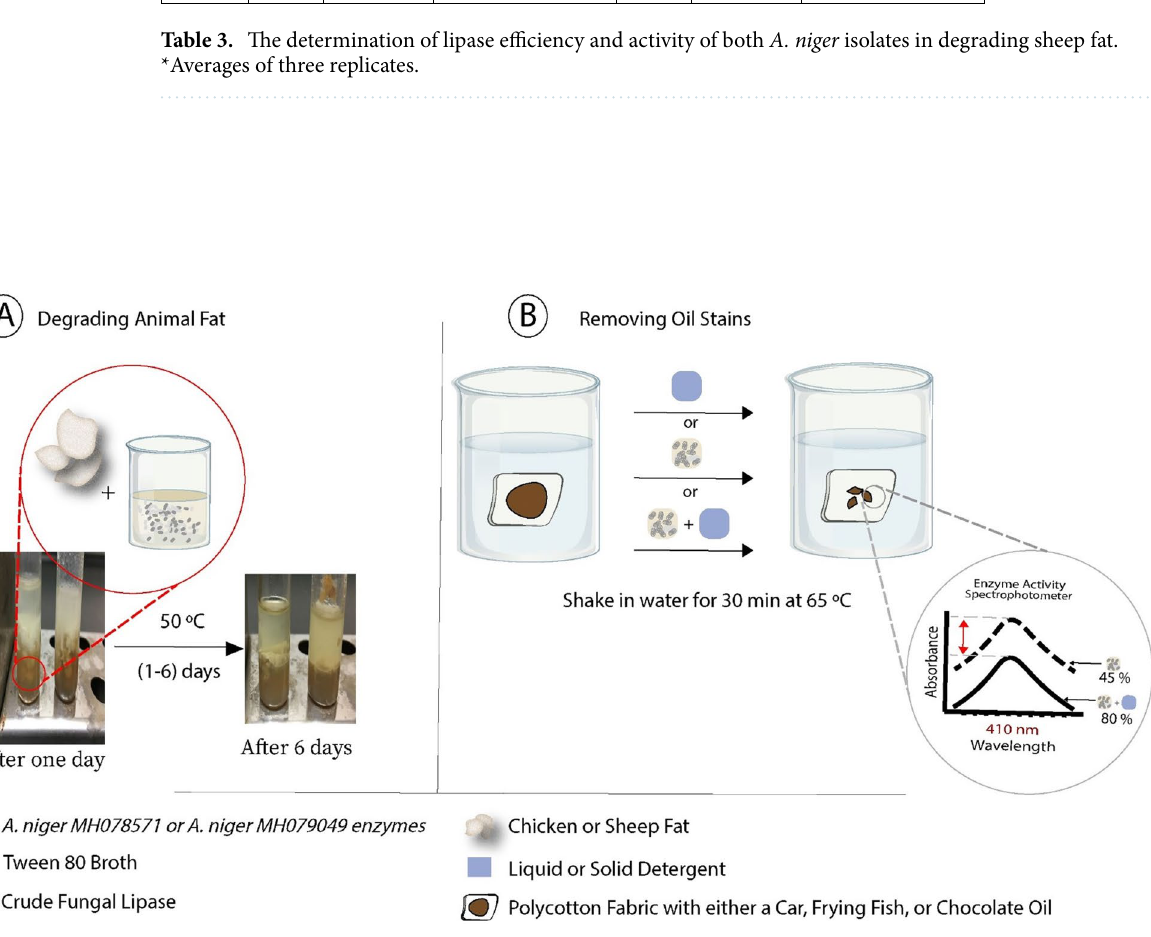
Figure 2. A summary of the main steps conducted to validate the industrial application of using lipase enzymes produced by A. niger MH078571.1, and A. niger MH079049.1 to ( A ) degrade animal fat and ( B ) remove oil wastes 36